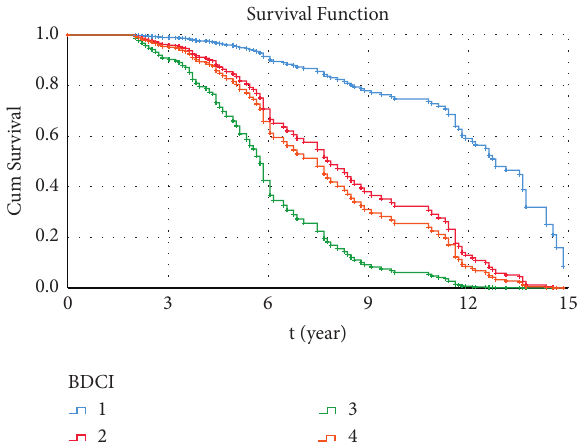
Figure 5: Survival curves for each level of the bridge deck